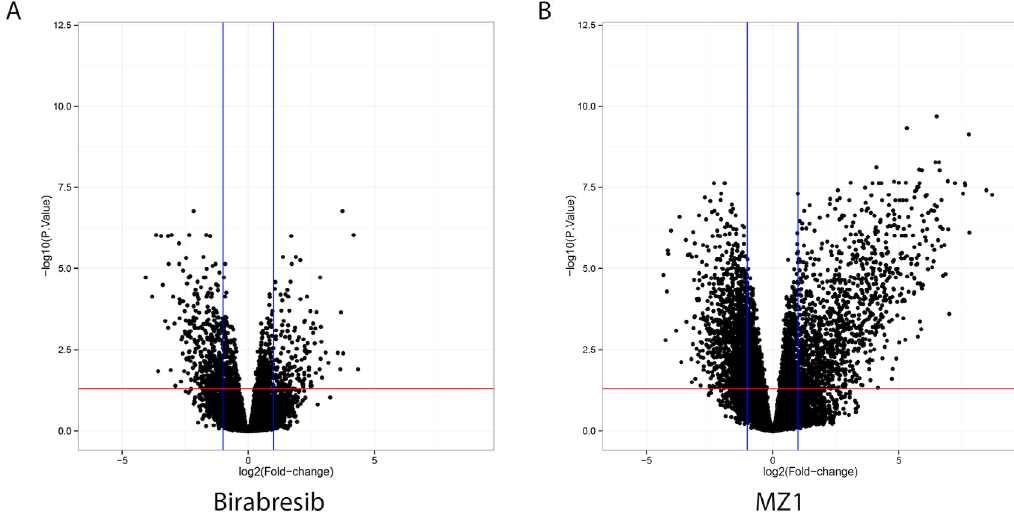
Figure 4. Volcano plots showing significantly upregulated (right quadrant in each plot) or down-regulated (left quadrant in each plot) transcripts after exposure to MZ1 (right panel) or birabresib (left panel) in two ABC DLBCL cell lines. Both MZ1 and birabresib were compared with DMSO. Y axis, log10-adjusted P -value; X axis, log2-fold changes after birabresib or MZ1